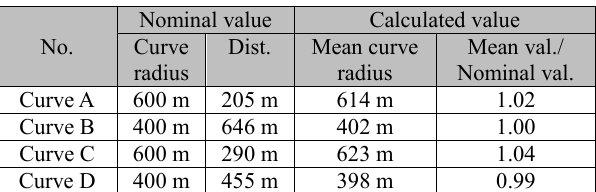
Table 3. Comparison of automatically calculated curve radius and nominal value of curve radius